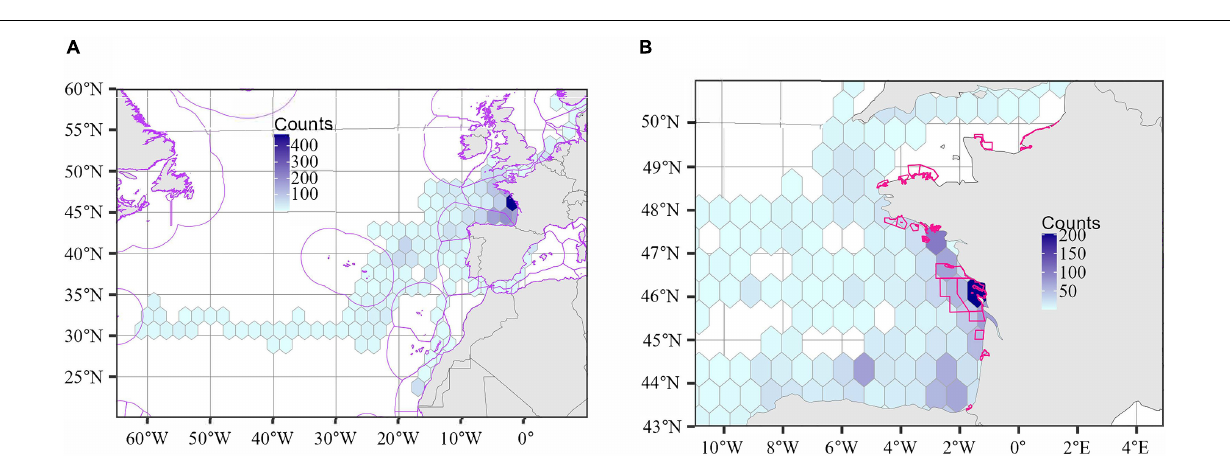
Figure 8A , logistic model estimate for BoB = − 0.30, p < 0.001 and south = − 0.16, p <